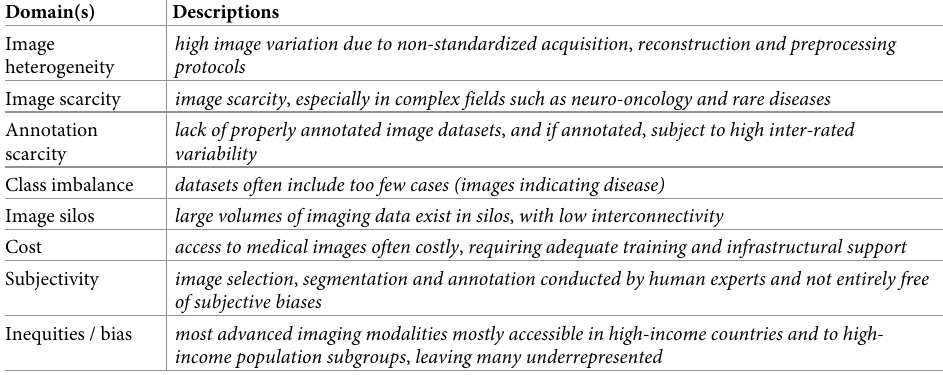
Table 3. Image-related challenges of machine learning, as reported in the